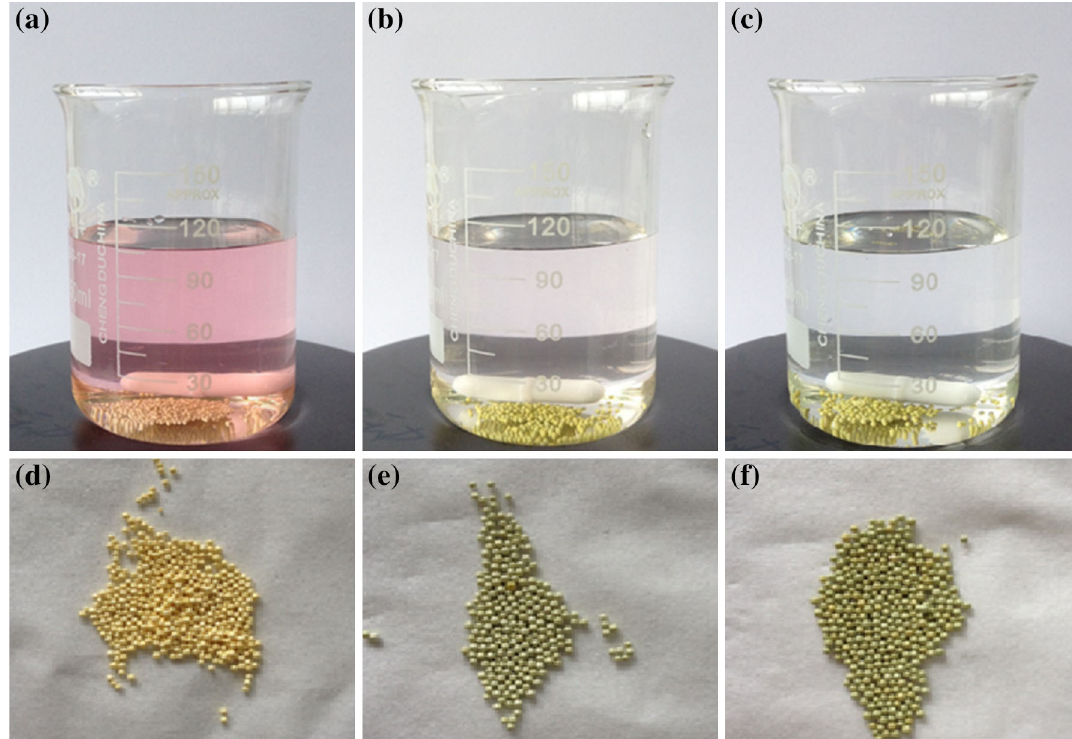
Fig. 2 Simulated wastewater after a 0, b 60 and c 120 min with the addition of DTC resin; the prepared DTC resins d before and e after the usage for wastewater treatment and f after four desorption–adsorption